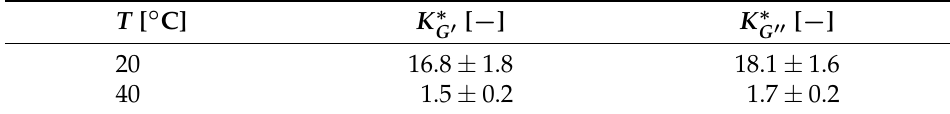
Figure 9. Magnetorheological effect at B = 500mT over the particle volume fraction for the storage and loss modulus in the swollen and deswollen state. Three samples per w s are shown. Error bars are smaller than the symbols. Table 3. Slopes for a linear scaling of MRE Ref with φ p in Figure